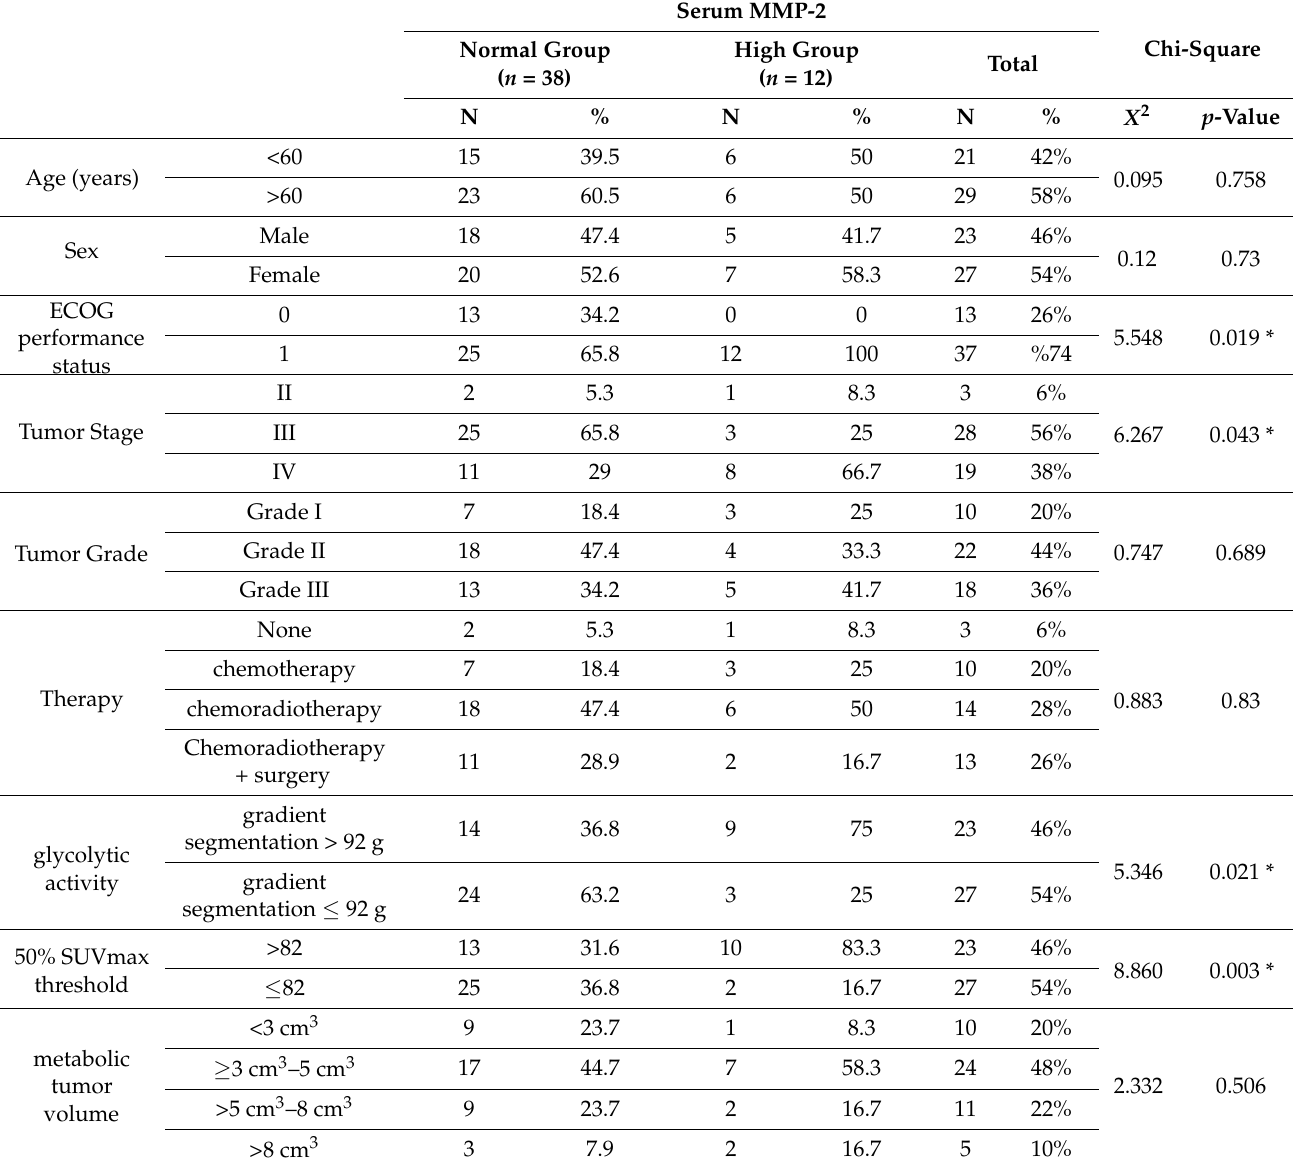
Table 7. Correlation between serum MMP-2 and the patients’